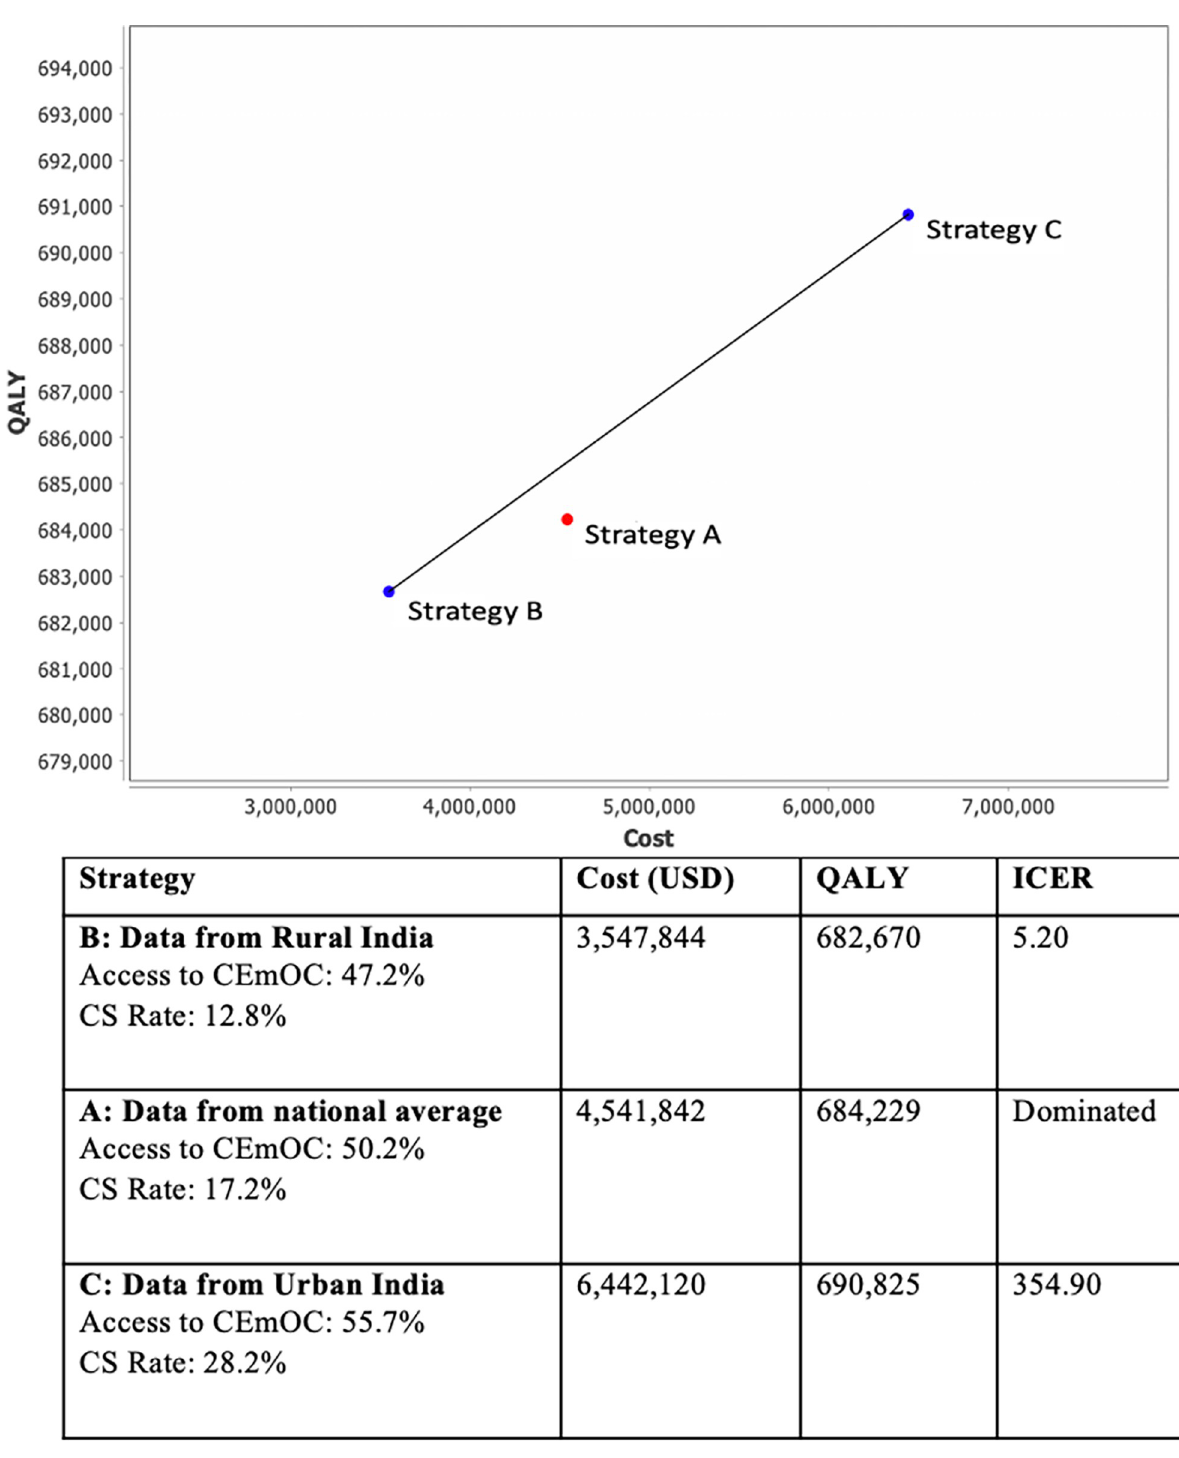
Fig 2. Cost and QALY for each of the strategies to scale up CS care. Plot of cost [USD] and utility [QALY] for the three strategies modelled and corresponding costs, quality-adjusted life years [QALY], and incremental cost-effectiveness ratio [ICER]. The strategies reflect equitable provision of cesarean sections for all of India based on existing national data [Strategy A], rural data [Strategy B] and urban data [Strategy C].